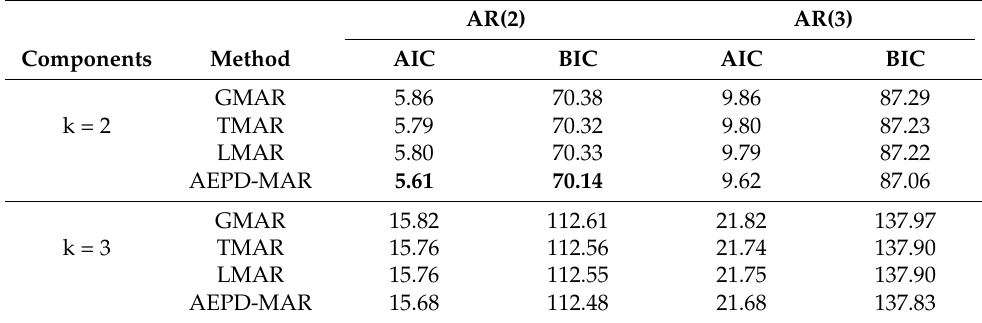
Table 9. AIC and BIC of a real dataset.